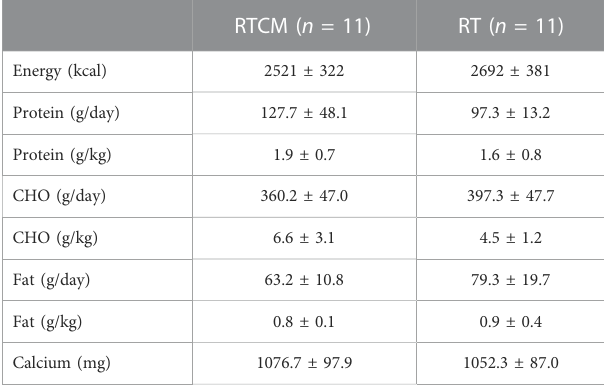
TABLE 1 Total daily nutrient intakes from food diaries for all group.